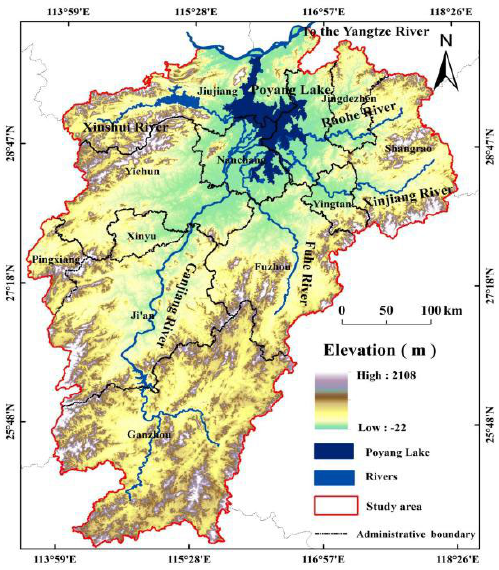
Figure 1. The geographical location of the study area.